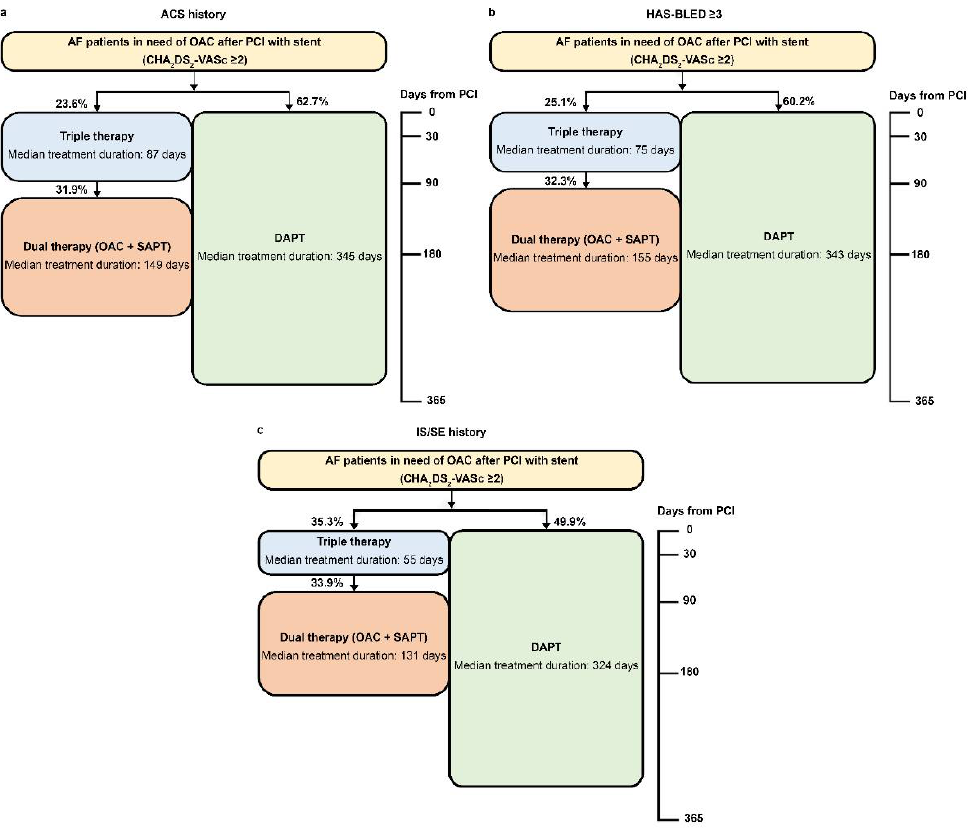
Figure 4. Antithrombotic treatment after percutaneous coronary intervention in patients with atrial fibrillation in need of oral anticoagulants. ( a ) ACS history; ( b ) HAS-BLED ≥ 3; ( c ) IS/SE history. CHA 2 DS 2 -VASc — congestive heart failure, hypertension, age ≥ 75 years, diabetes mellitus, stroke, vascular disease, age 65–74 years, and sex. HAS-BLED — hypertension, abnormal renal and liver function, stroke, bleeding, labile international normalized ratio, elderly, drugs or alcohol. AF, atrial fibrillation; DAPT, dual antiplatelet therapy; IS/SE, ischemic stroke/systemic embolism; OAC, oral anticoagulants; PCI, percutaneous coronary intervention; SAPT, single antiplatelet therapy. Triple therapy means OAC plus DAPT. Dual therapy means OAC plus SAPT. DAPT means aspirin plus clopidogrel/prasugrel/ticagrelor. OAC monotherapy means apixaban, dabigatran, rivaroxaban, or warfarin. SAPT means aspirin, clopidogrel, prasugrel, or ticagrelor. Proportions were calculated from 7749 patients excluding patients who had other treatments.